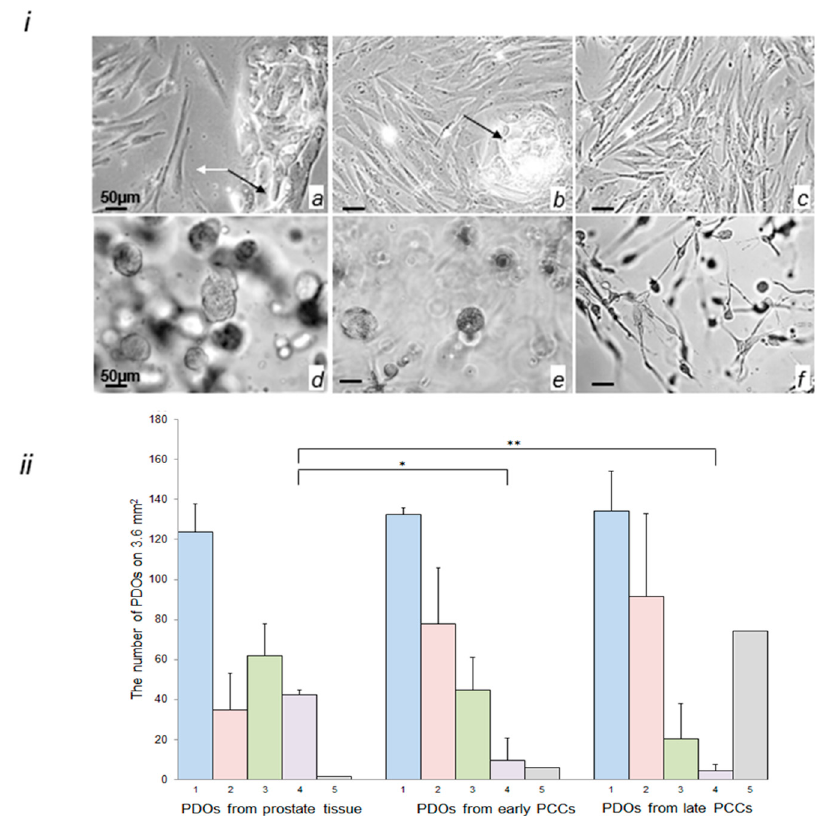
Figure 3. Morphological characteristics of early and late PCCs and PDOs derived from prostate tissue and early and late PCCs. ( i ) Representative images of early PCCs (Figure 3i ( a , b )), late PCCs (Figure 3i ( c )), PDOs derived from prostate tissue (Figure 3i ( d )), and PDOs derived from early (Figure 3i ( e )) and late (Figure 3i ( f )) PCCs. Images were obtained using an Axiovert 200M microscope (Carl Zeiss, Oberkochen, Germany) equipped with a DFC420 camera in the phase contrast mode; epithelial cells—black arrows; mesenchymal cells—white arrows; objective, 20 × /0.5; image size, 1728 × 1296 pixel. ( ii ) The number of different-size PDOs derived from the prostate tissue, early PCCs, and late PCC (n = 3; 20 images per group; mean ± SD); 1—total number of PDOs, 2—the number of small-size PDOs (10–25 µ M), 3—the number of medium-size PDOs (26–50 μ M), 4—the number of large-size PDOs (51–100 μ M), 5—the number of fibroblast-like PDOs, not included in the total number of PDOs; * p < 0.05, ** p < 0.01.